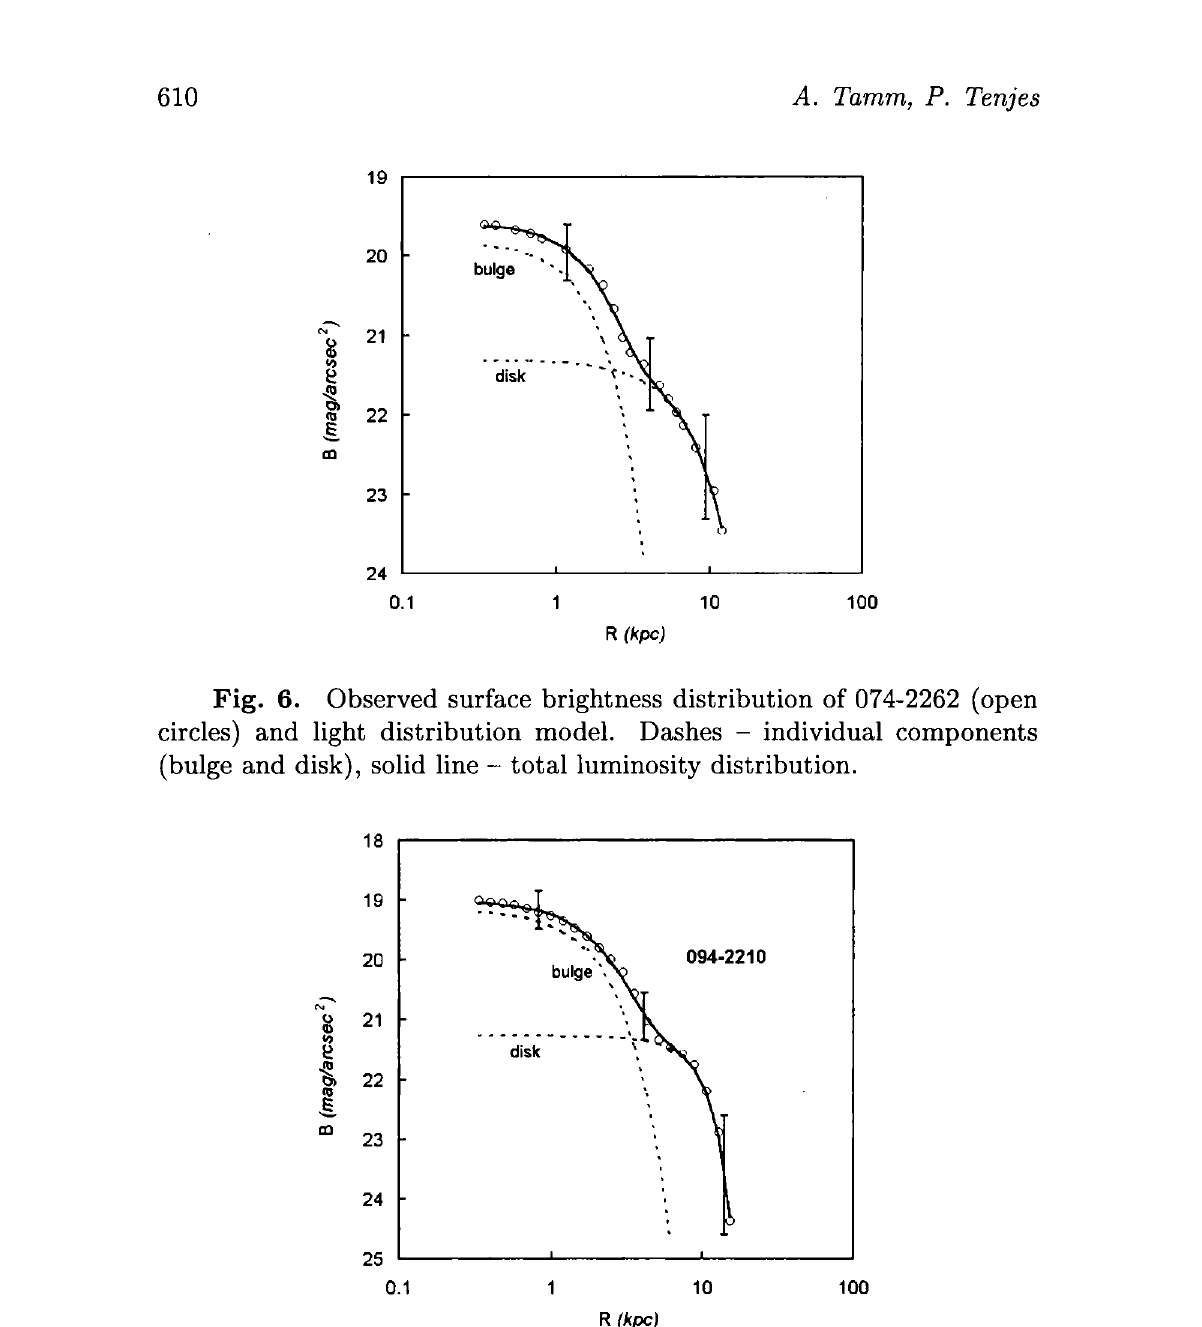
Fig. 7. Observed surface brightness distribution of 074-2262 (open circles) and light distribution model. Dashes - individual components (bulge and disk), solid line - total luminosity